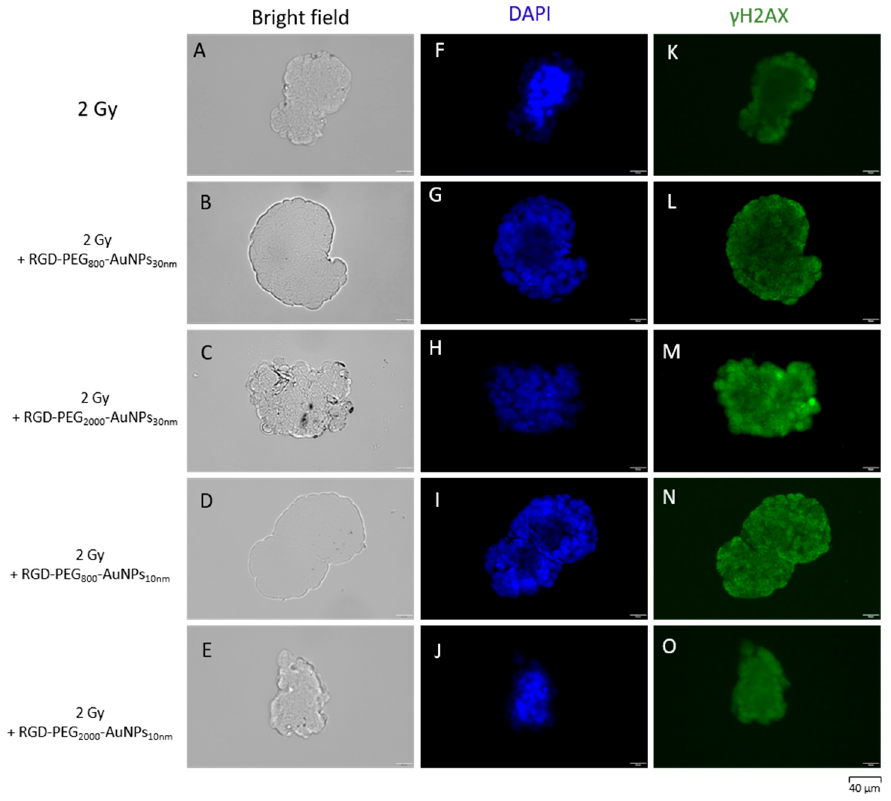
Figure 11. The immunofluorescence of γ H2AX after cell exposure to 2 Gy and dose of 2 Gy with the previous 50 min incubation with AuNPs in the 3D model. The morphology of cells was presented in the bright field ( A – E ). The nuclei of cells were dyed with DAPI solution ( F – J ). The γ H2AX foci were dyed using the solution in green (488 nm) ( K – O ).